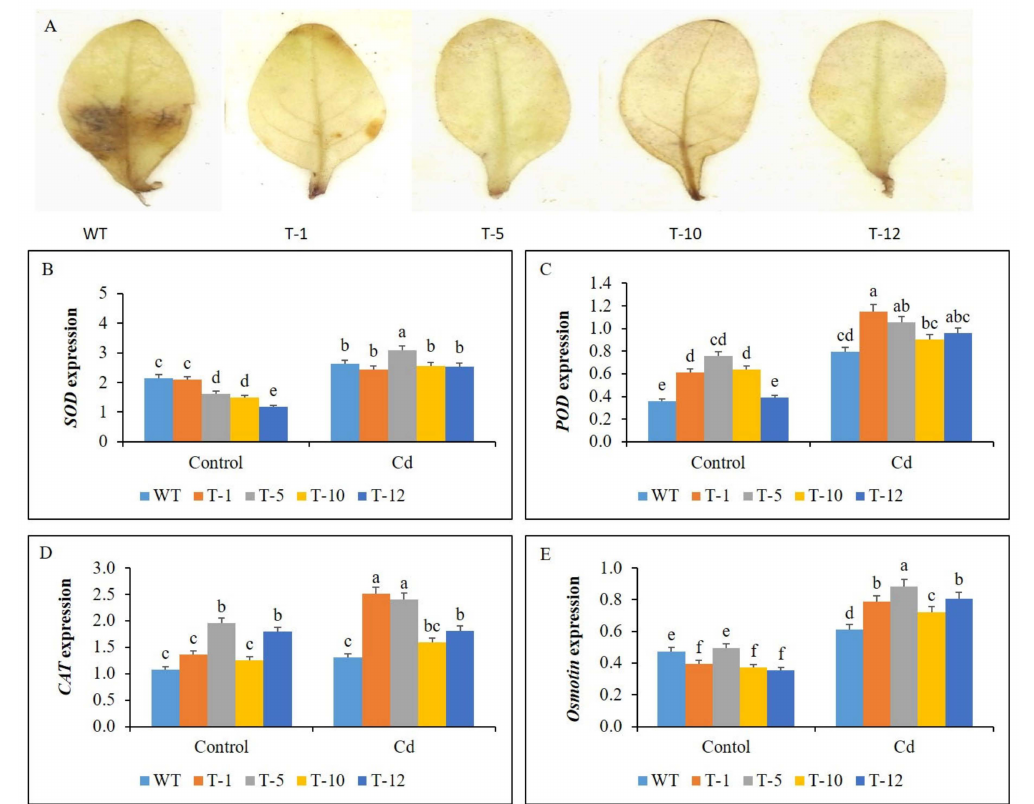
Figure 7. Illustration of hydrogen peroxide (H 2 O 2 ) accumulation ( A ) in the leaves of WT and transgenic petunia cv. ‘Mirage Rose’ plants under cadmium (Cd) stress, and comparison of the expression levels of SOD ( B ), POD ( C ), CAT ( D ), and Osmotin ( E ) in their leaves under control and cadmium (Cd) stress. Data represent the means of three replicates and error bars indicate standard error. Means with the same letters are not significantly different by least significant difference test (LSDT, p < 0.05).